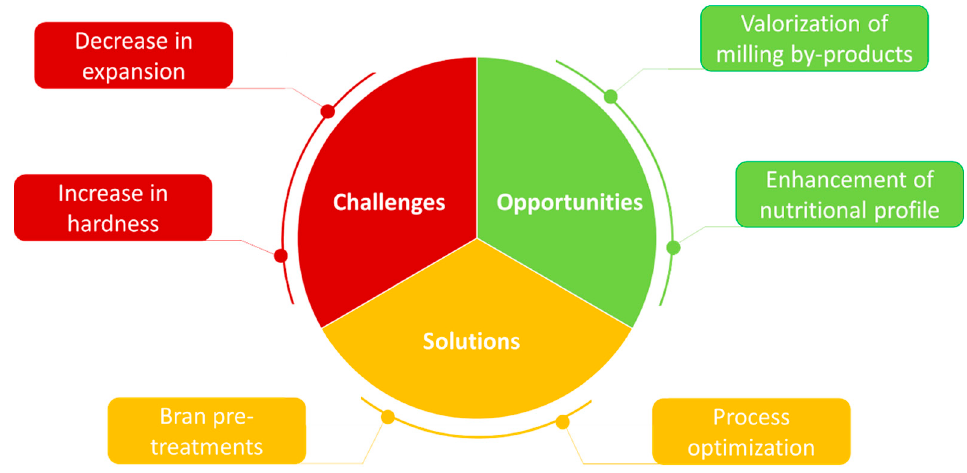
Figure 1. Motivations for enriching extruded snacks with bran, as well as potential issues and strategies to address